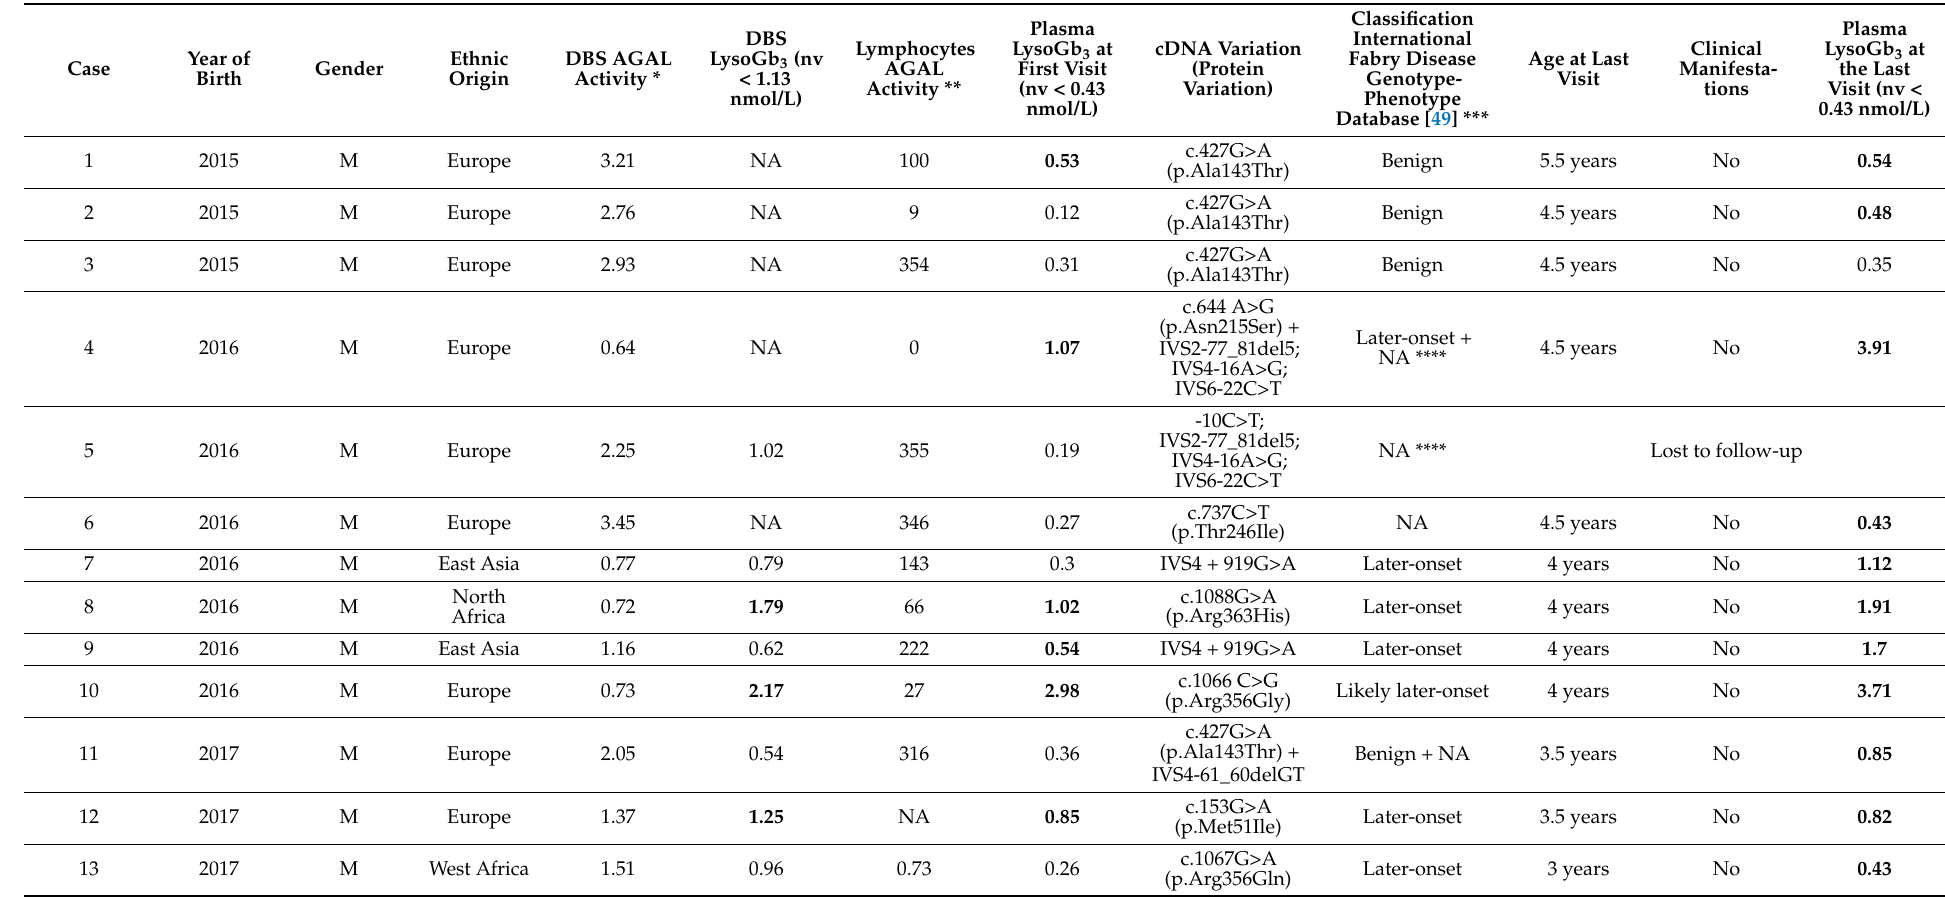
Table 3. Clinical, biochemical, and molecular results of the patients detected by newborn screening for Fabry disease: baseline and